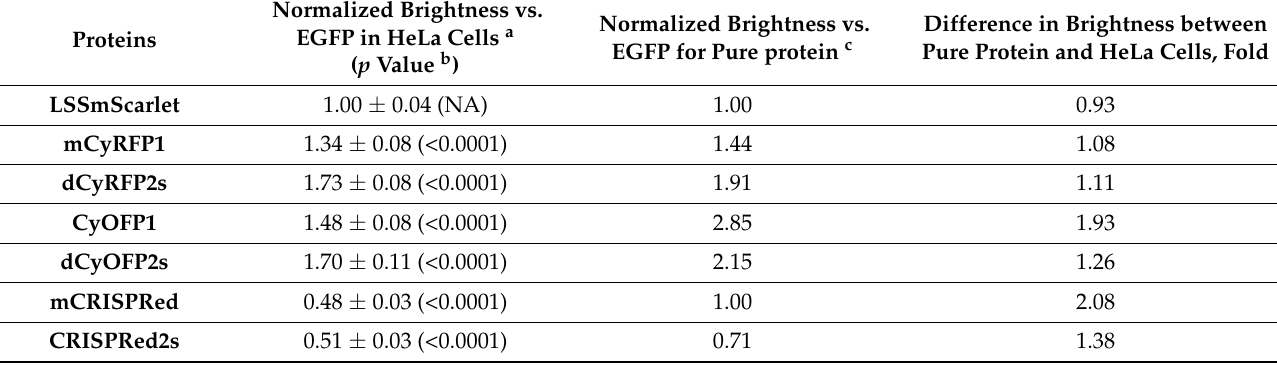
Table 2. Brightness of LSSRFPs in HeLa cells at 488 nm excitation. a Brightness of LSSRFPs normalized to the brightness of the LSSmScarlet protein was estimated in HeLa cells relative to EGFP in LSSRFPs-P2A-EGFP fusion using the same 488 nm excitation light and 525/50 BP and 617/73 BP emission filters for EGFP and LSSRFPs, respectively. b Statistical significance of the difference between the normalized brightness for LSSmScarlet and the respective LSSRFP. NA, not applicable. c Brightness of the purified proteins corrected for decreased absorption at 488 nm excitation from Table 1 normalized to the brightness of LSSmScarlet. Normalized Brightness Proteins